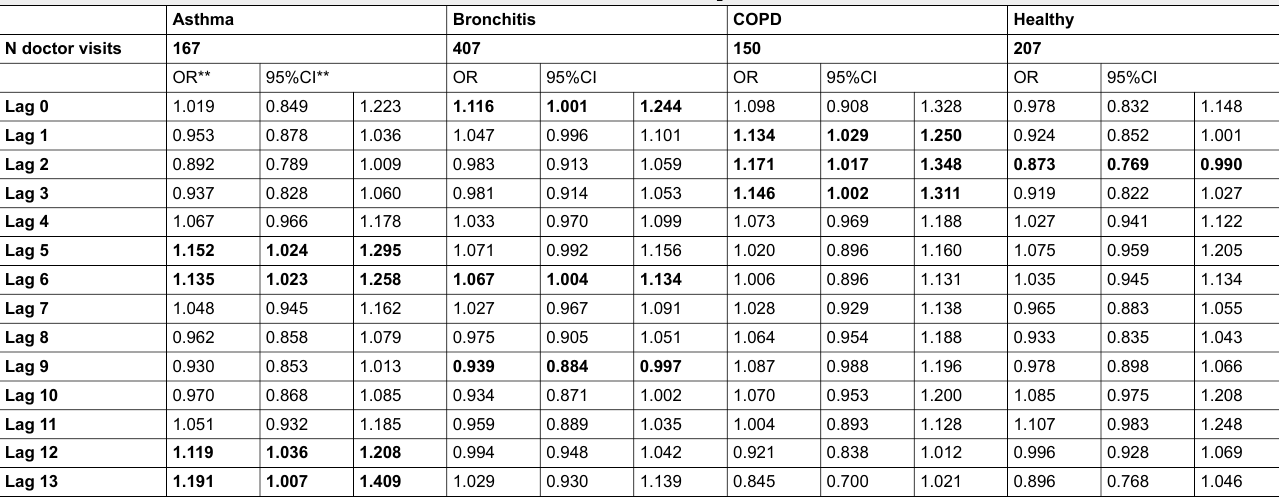
Table 3: Adjusted OR's* for doctor’s visit for respiratory symptoms per 10 µg/m 3 increase in NO 2 . Asthma Bronchitis